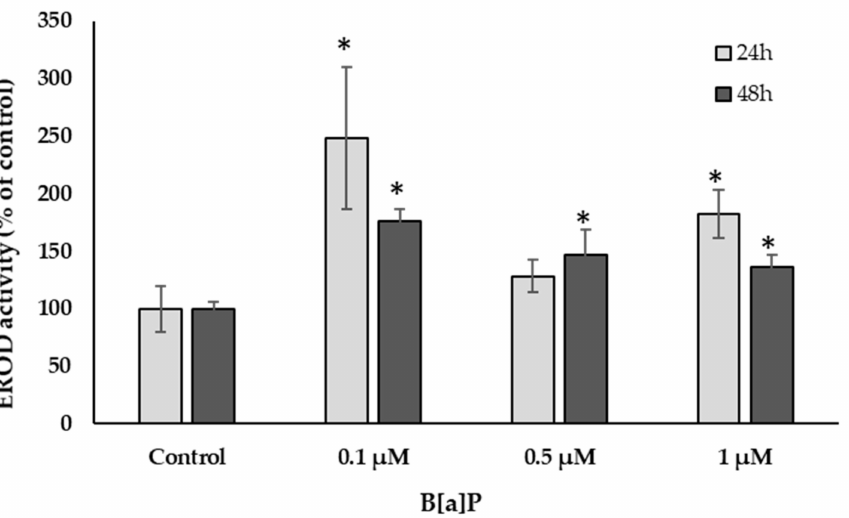
Figure 5. EROD activity of S. aurata primary hepatocytes exposed to different concentrations of Benzo(a)pyrene (B[a]P) for 24 and 48 h. Ethoxyresorufin O-Deethylase (EROD) activity is expressed relative to control cells (DMSO). Values are mean ± SE of 4 to 5 independent extractions. A significant difference was observed between the control and T 24 and T 48 ; * p <